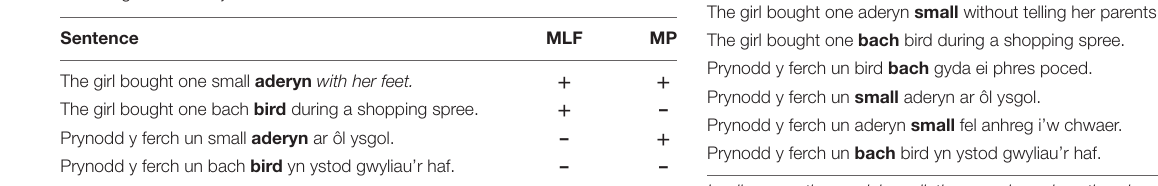
In all cases, the model predictions are based on the placement of the adjective. The critical adjective is highlighted in bold. An example of a semantically aberrant sentence ending is highlighted in italics, though note that these incongruent completions were dispersed equally between conditions. Italics and bold font are for the reader’s information and were not used in the